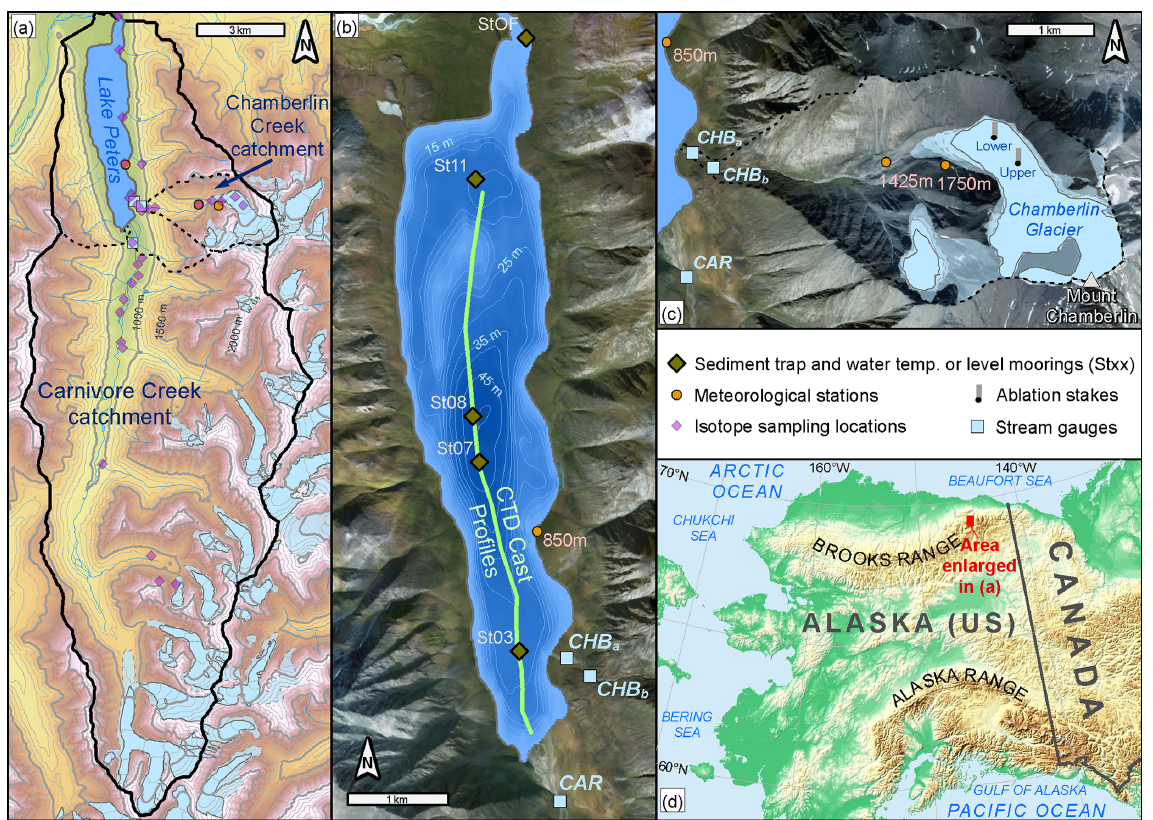
Figure 2. (a) Lake Peters catchment (solid black boundary) and Carnivore Creek and Chamberlin Creek sub-catchments (dashed boundaries) with land-based observational locations. (b) Lake Peters bathymetry and lacustrine observational locations. (c) Chamberlin Creek sub- catchment and Chamberlin Glacier. (d) Brooks Range setting in Alaska and study area location.